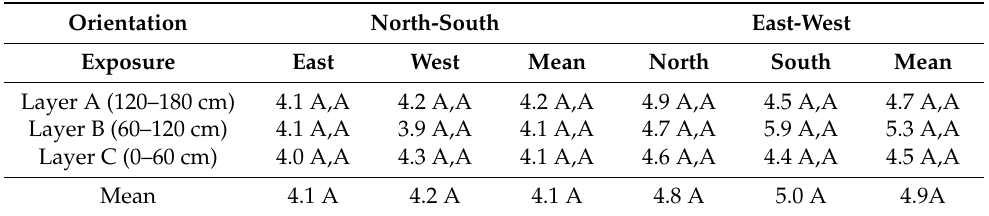
Table 10. Mean weight of hulled almonds (AW, g). The first letters denote significant differences between layers for a given exposure; the second letters denote significant differences between exposures for a given layer (SNK test). Lower case letters denote statistical differences with p = 0.05. Capital letters denote statistical differences with p =